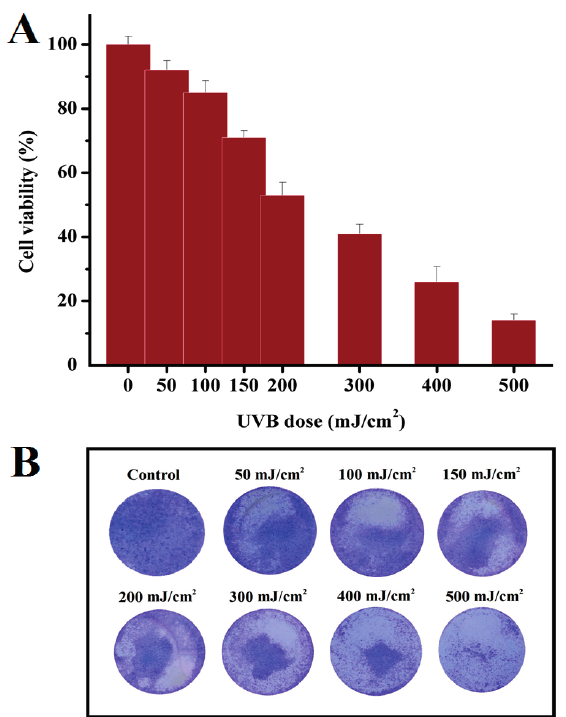
Figure 1. Cell proliferation rate in UVB irradiated HaCaT cells. ( A ) Viability assessed by MTS assay 24 h after UVB irradiation. The bar graph depicts the percent cell viability compared to control and represent the mean percentage ± S.D. (standard deviation) of three independent experiments. ( B ) Colony formation assay. Representative photomicrographs of survival colonies after different doses of UVB, stained with crystal violet